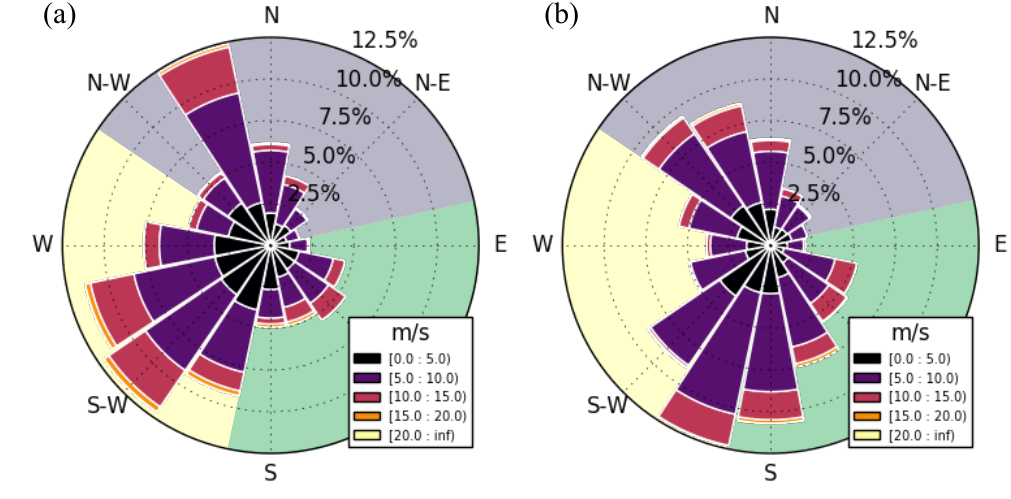
Figure 4. Wind roses from Utö ( a ) and Isokari ( b ) AWS June 18–November 13, 2013. Directions are given as the direction from where the wind is blowing. S (green), W (light yellow) and N (grey) sectors used in the study of strong current events are indicated on the background of the wind